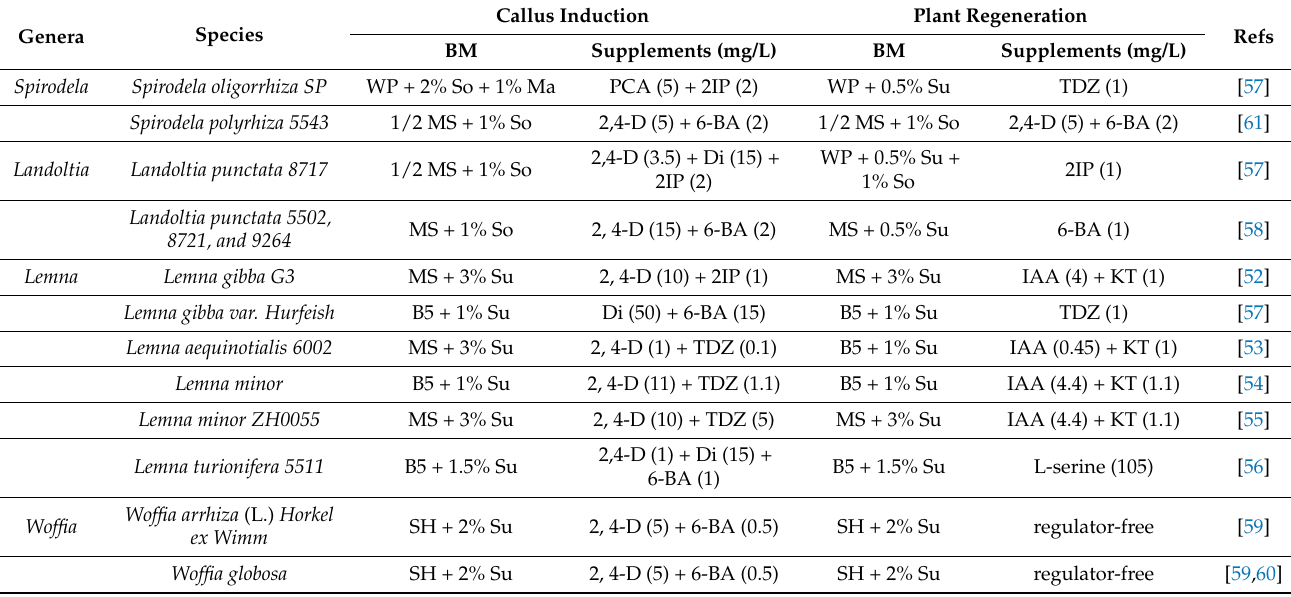
Table 4. Tissue culture of